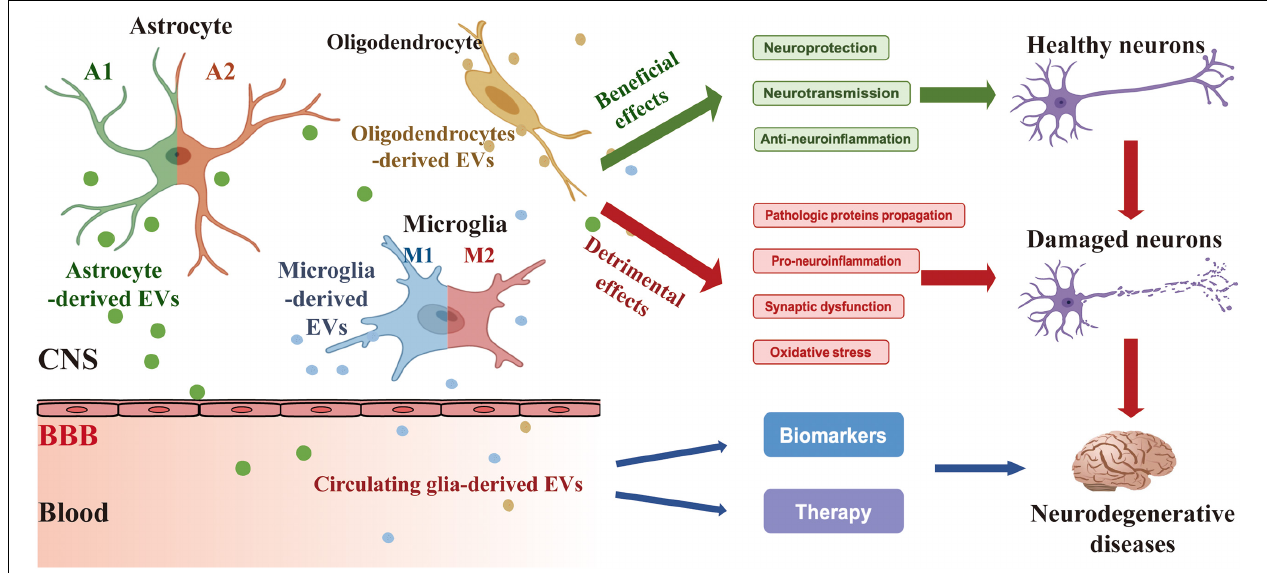
FIGURE 1 | Secretion of EVs derived from glia (astrocyte, microglia, and oligodendrocyte) and their effects on neurons and ND. Glia-derived EVs have a beneficial and/or detrimental impact on the process of ND like a “double-edged sword.” Under condition normal circumstances, glia-derived EVs contribute to neuroprotection, neurotransmission, and anti-neuroinflammation. However, in response to the different stimuli such as toxic aggregated proteins and neuroinflammation, glia-derived EVs modify their cargo content and have detrimental effects on pathologic proteins propagation, pro-neuroinflammation, synaptic dysfunction, and oxidative stress. In addition, circulating glia-derived EVs hold considerable potential for clinical applications in the diagnosis and treatment of ND. CNS, central nervous system; BBB, blood-brain barrier.